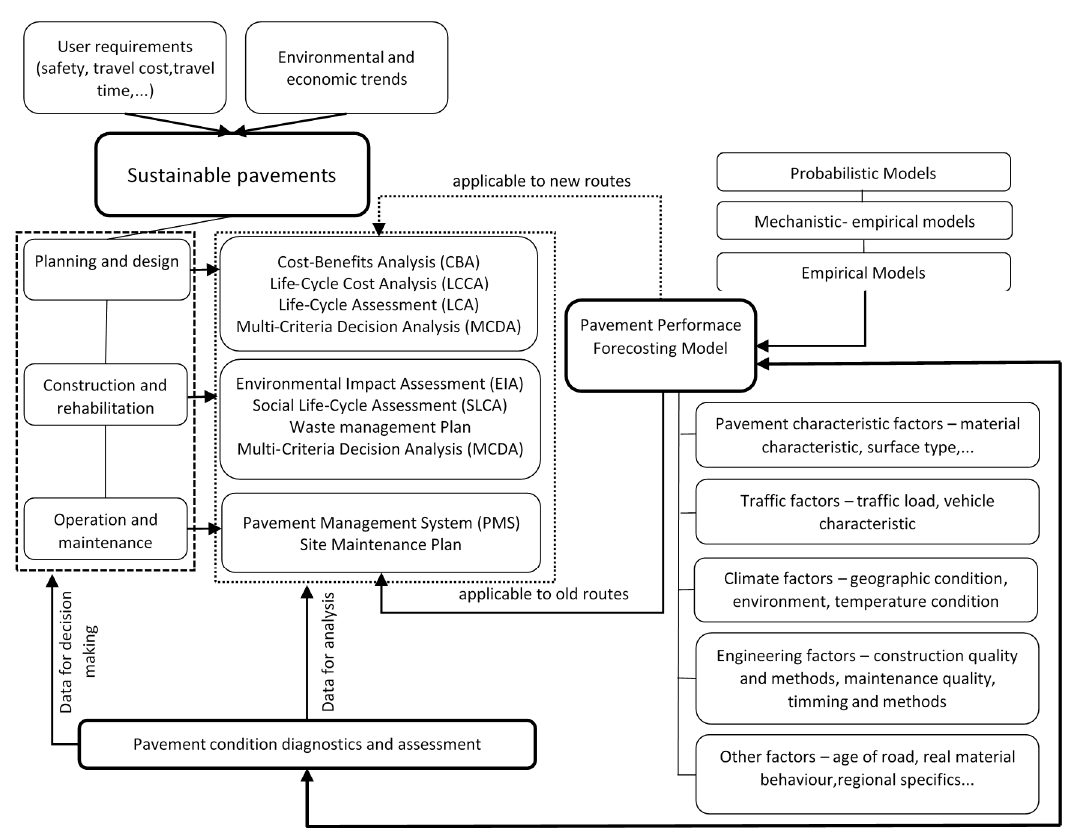
Figure 1. The position of the pavement management system in the general philosophy of the pavement sustainability [3,4].